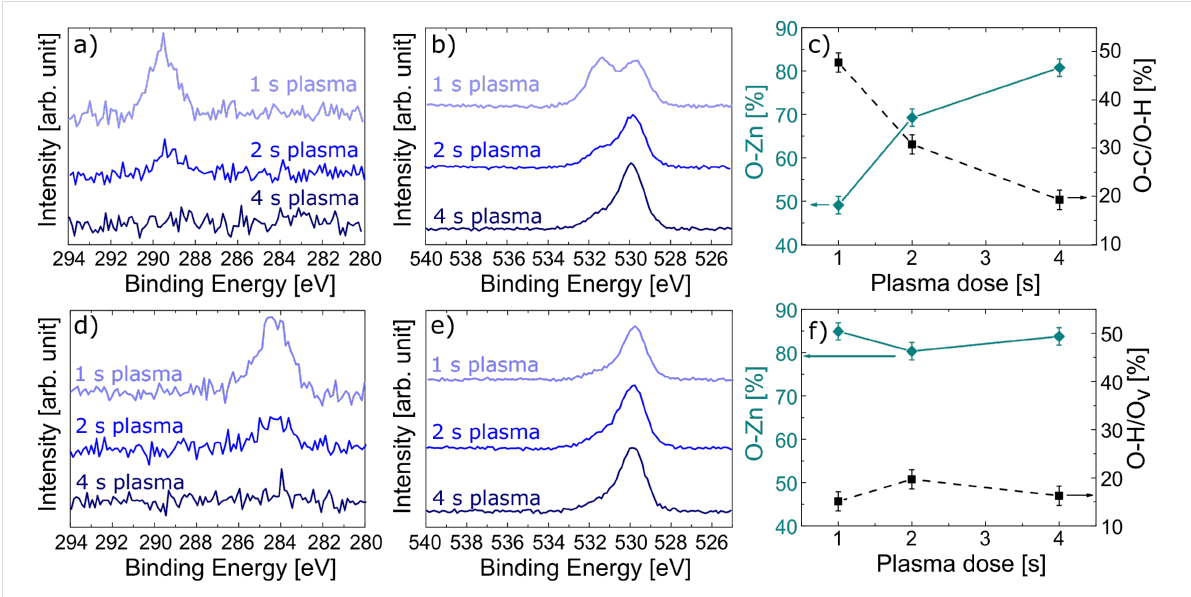
Figure 2: High-resolution XPS spectra of the pristine (a–c) and annealed (d,e) zincone-like layers acquired after 60 s Ar + sputtering. Pristine: a) C 1s HR spectrum and b) O 1s HR spectrum as a function of the plasma pulse time. c) Relative amount of the O–Zn and O–C/O–H as a function of the plasma pulse time as resulted from the O 1s peak fitting. Annealed: d) C 1s spectrum and e) O 1s spectrum as a function of the plasma pulse time. f) Relative amount of the lattice O–Zn and Zn hydroxides/defective oxygen as a function of the plasma pulse time, as resulted from the O 1s peak